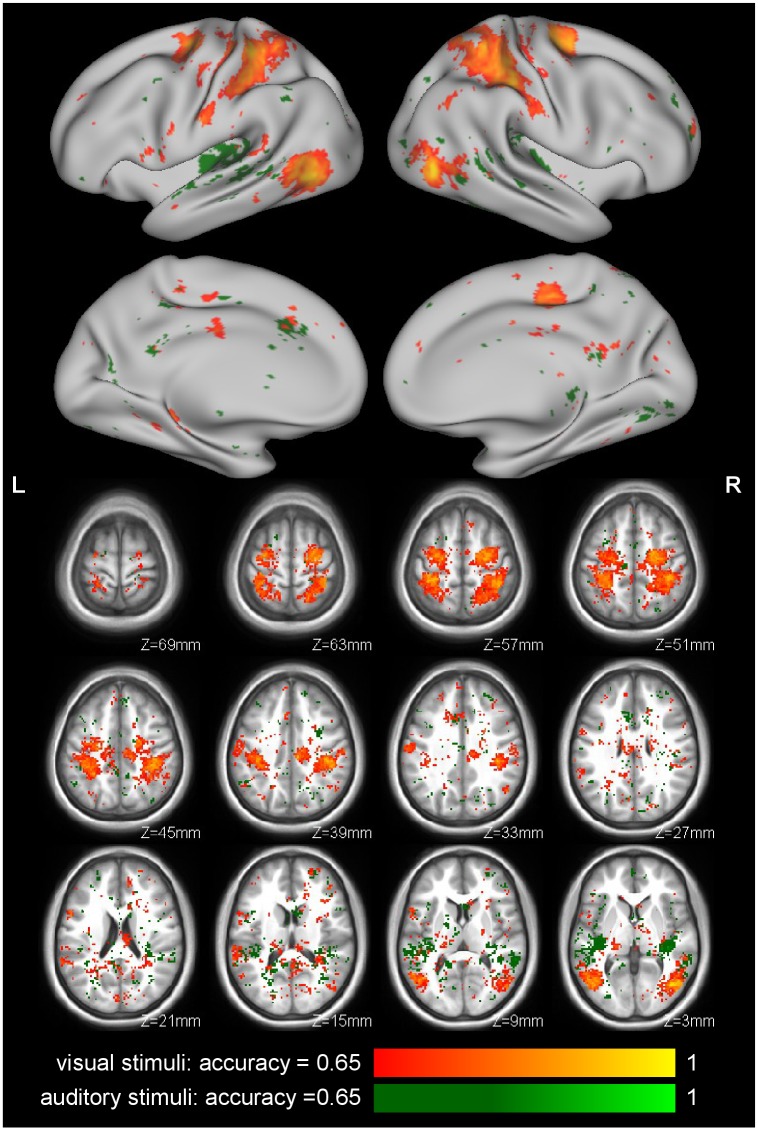
Action perception-specific responses identified by the MVPA searchlight analysis (2-voxel radius).Classification (leave-one-subject-out cross-validation) accuracies are shown for visual (orange) and auditory (green) stimuli. The visual stimuli resulted in high-accuracy searchlights in typical action observation regions, while information about the auditory stimuli was largely confined to auditory regions. For display, the classification accuracy map was thresholded at .65 and clusters of at least 20 voxels.